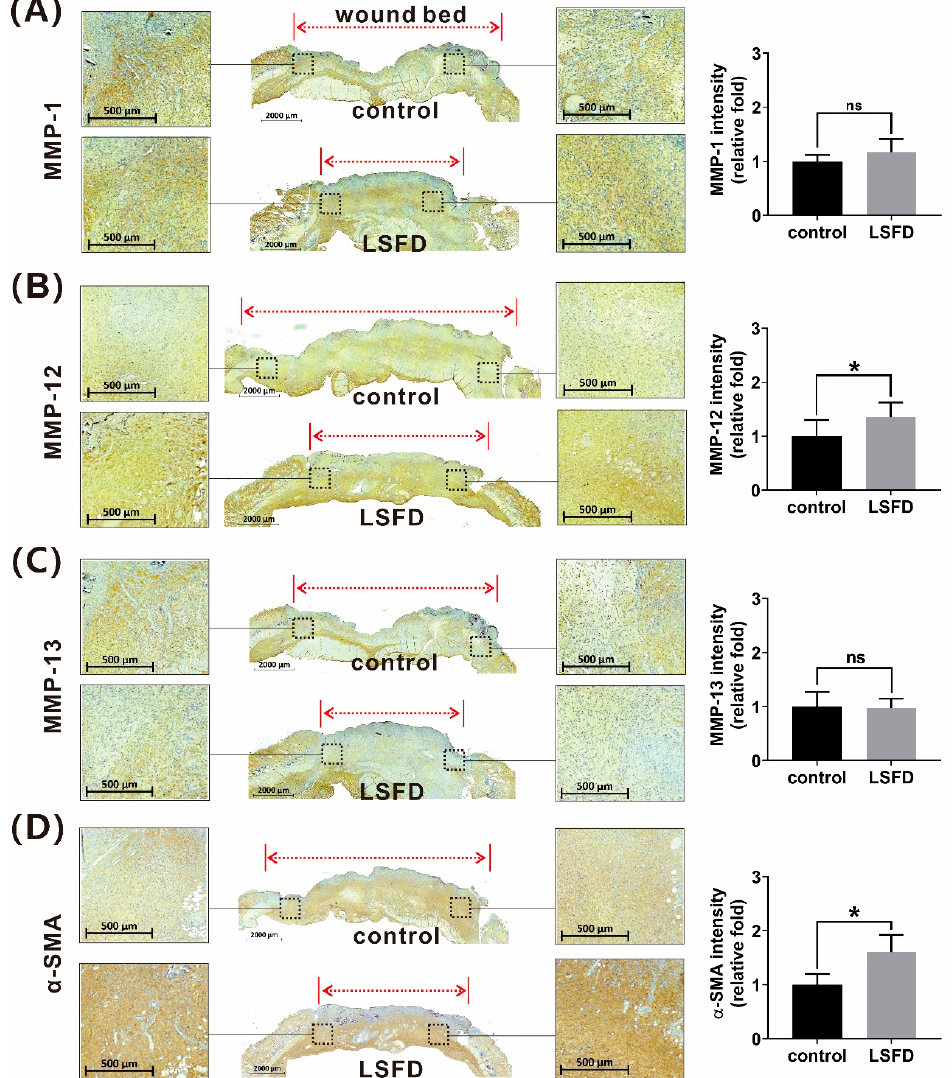
Figure 8. Immunohistochemistry staining of ( A ) matrix metalloproteinase-1 (MMP-1), ( B ) MMP-12, ( C ) MMP-13, and ( D ) α -smooth muscle actin ( α -SMA) in day-10 tissue sections of untreated burn wounds (control) and burn wounds treated with β -sheet lyophilized silk fibroin dressing (LSFD). Quantitative representations show the relative fold difference in integrin and MMP expression between the LSFD-treated group and the control group. Data are presented as the mean ± standard error of the mean ( n = 6; ns: not